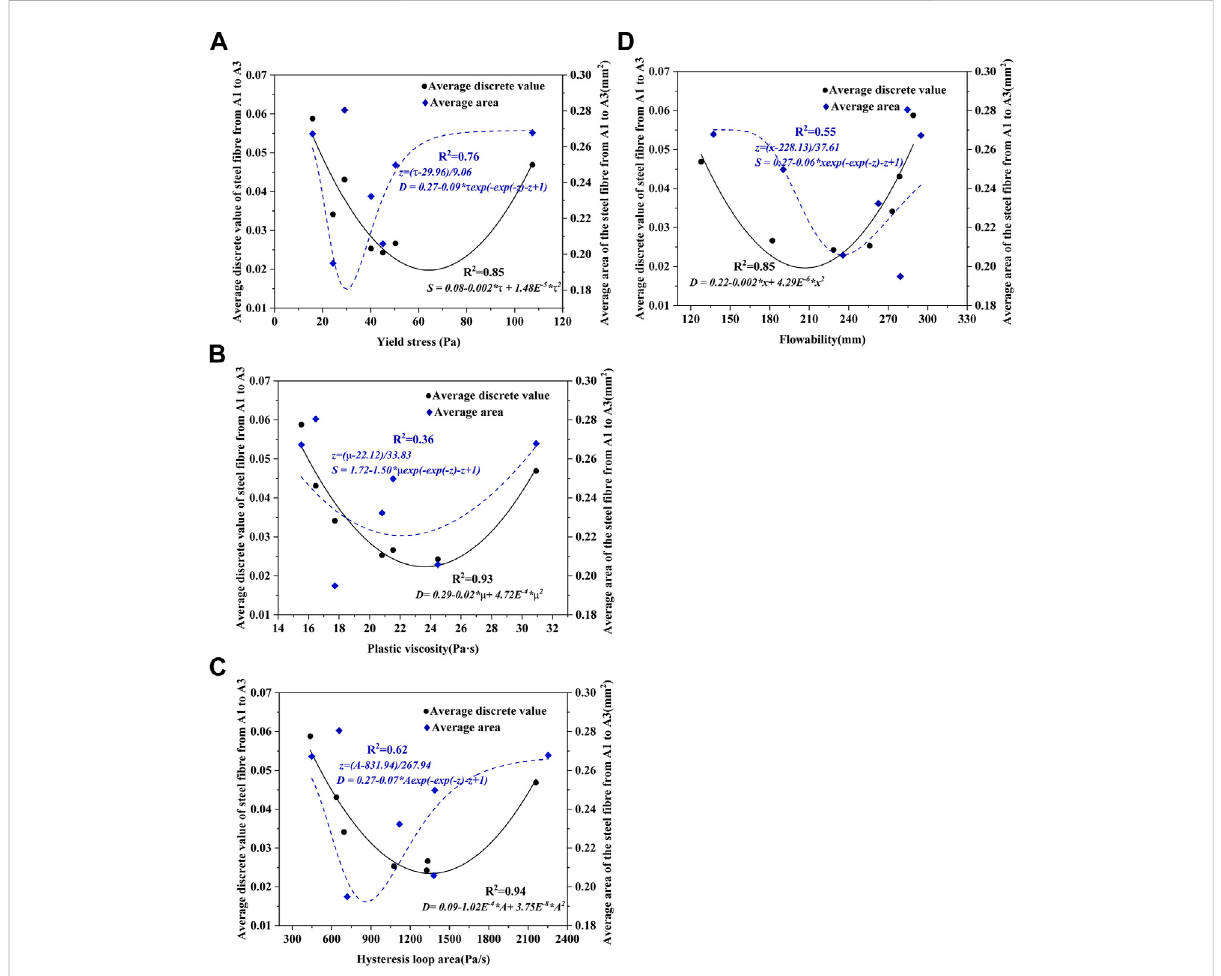
FIGURE 13 The evolution of D and S with (A) yield stress; (B) plastic viscosity; (C) area of thixotropic loop; (D) fl owability under different bentonite